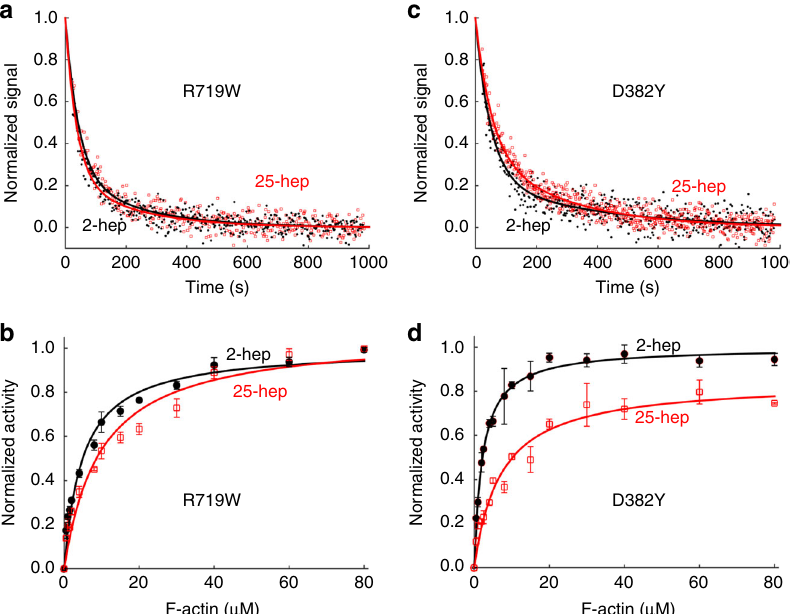
Fig. 5 Effect of PHHIS-converter domain interaction mutations R719W and D382Y on HMM ATPase kinetics. In all cases, black solid line and fi lled circles are 2-hep HMM data; red solid line and empty squares are 25-hep HMM data. a Mant-nucleotide single turnover kinetics for R719W 2-hep and 25-hep HMM. b Actin-activated ATPase data for R719W 2-hep and 25-hep HMM. c Mant-nucleotide single turnover kinetics for D382Y 2-hep and 25-hep HMM. d Actin-activated ATPase data for D382Y 2-hep and 25-hep HMM. a , c show representative data from one preparation each. Each of panels b and d are combined data from two independent preparations of HMMs with three experimental replicates for each preparation. Each point is an average with the error bar representing the SEM. Source data are provided as a Source Data fi